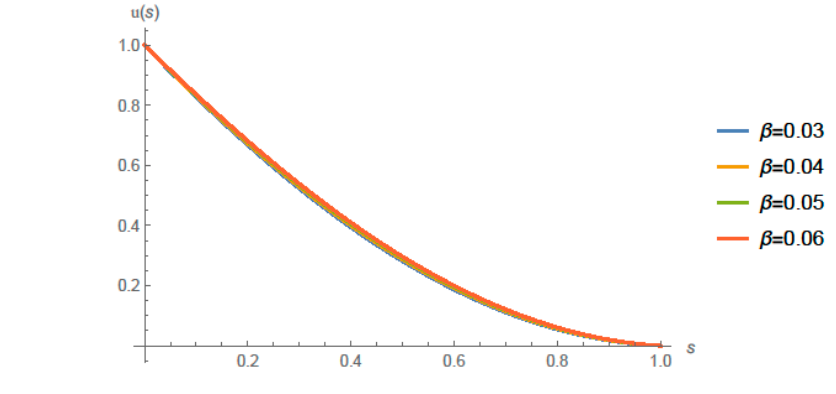
Figure 2. u ( s ) at di ff erent values of β . Figure 2. 𝑢(𝑠) at different values of β .